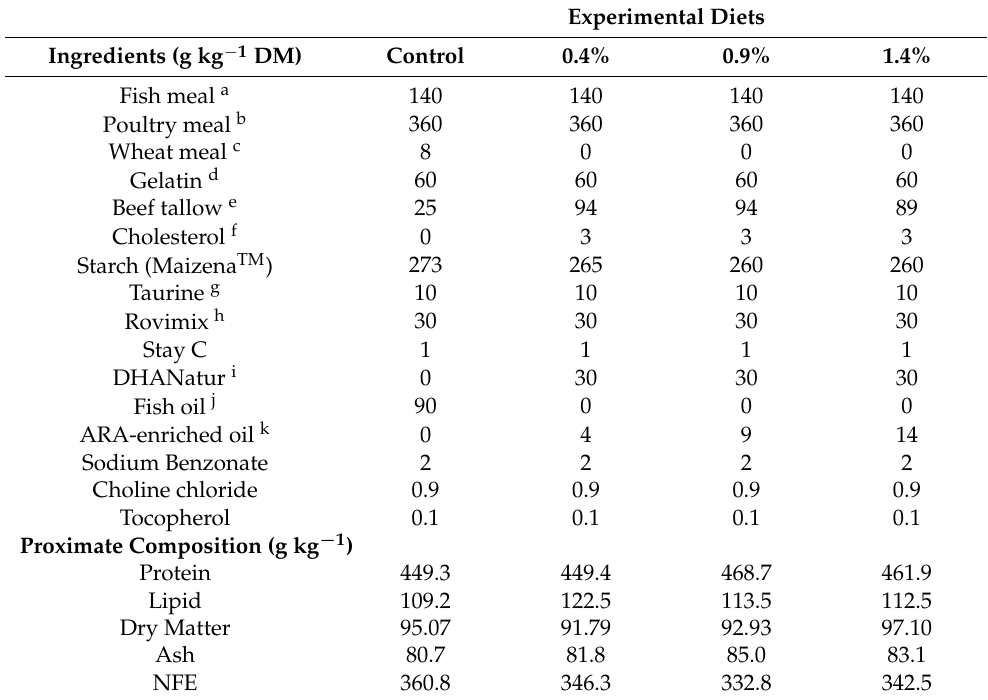
Table 1. Ingredient formulation (g kg − 1 ) and proximate composition of diets used to fed S. dorsalis containing increasing levels of ARA. The dietary formulations are presented as fed-basis and proxi- mate composition in g kg − 1 on a dry matter